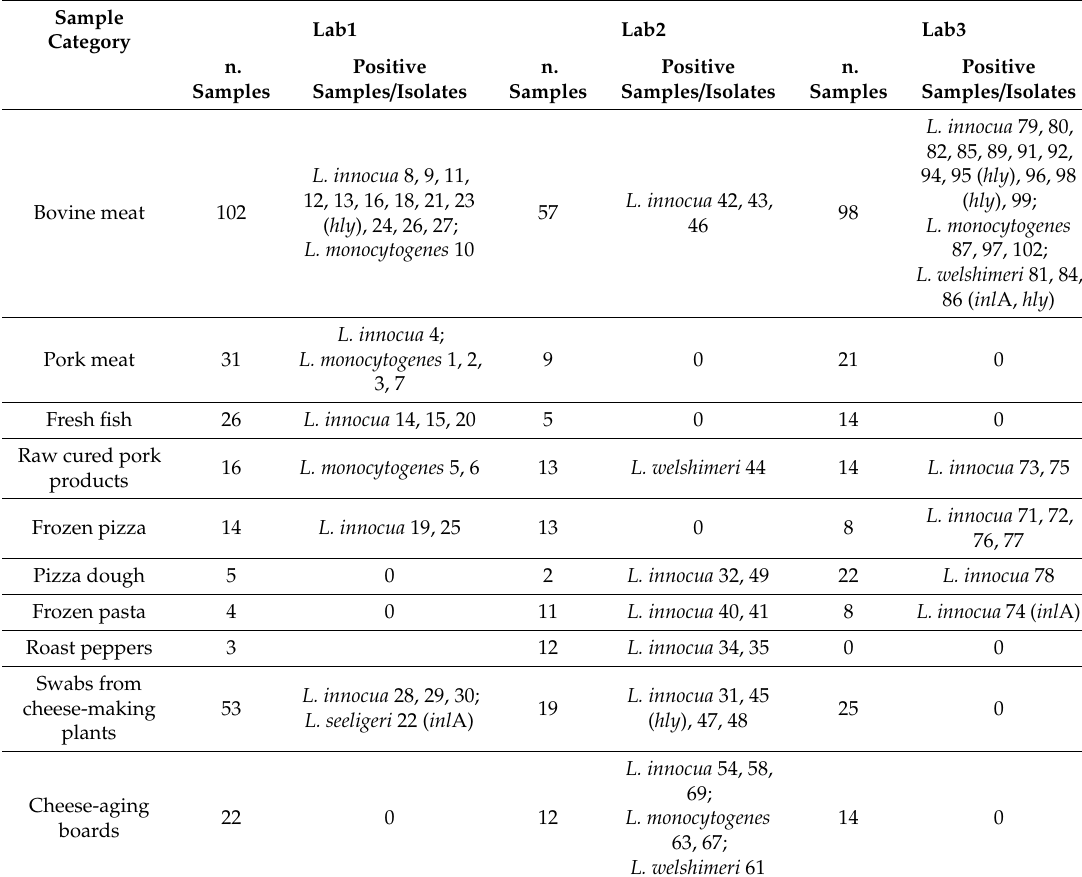
Table 1. Number of samples analyzed by each laboratory, sample categories and respective Listeria spp. isolates as identified by molecular assays in this study. The L. monocytogenes virulence genes found in isolates of other Listeria species are reported adjacent to the respective